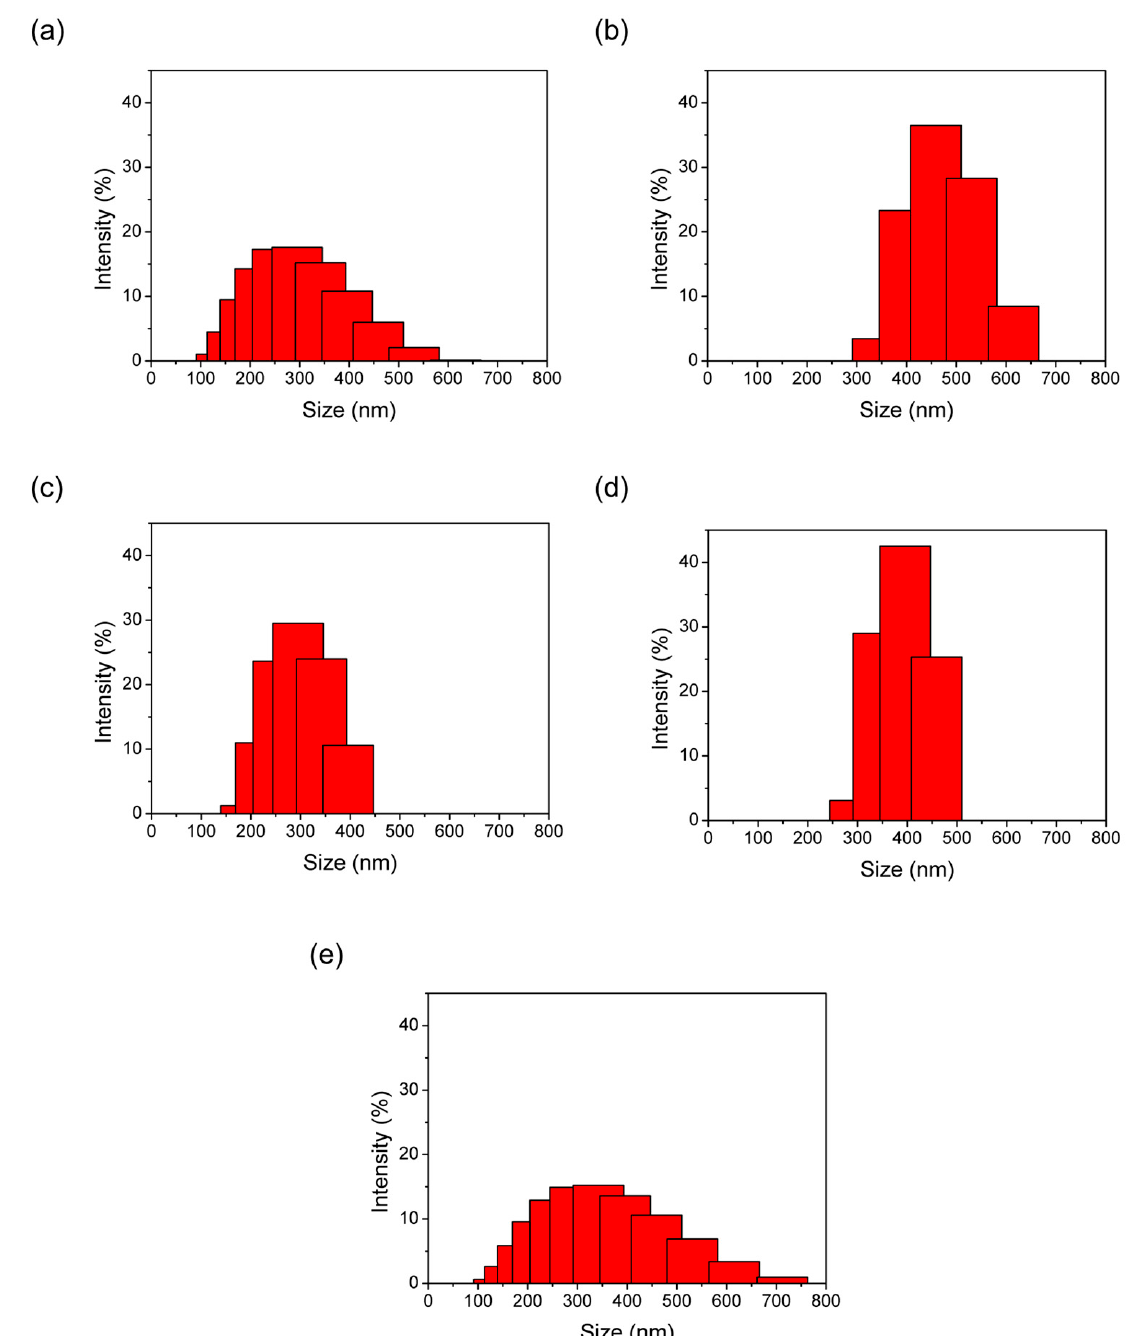
Figure 5. The DLS analysis of ZIF-8 samples with de novo- synthesis and impregnation methods using AgNO 3 as the precursor. ( a ) ZIF ( b ) 04AgNO@ZIF (de novo), ( c ) 08AgNO@ZIF (de novo), ( d ) 01AgNO/ZIF (impregnation), ( e ) 02AgNO/ZIF (impregnation).